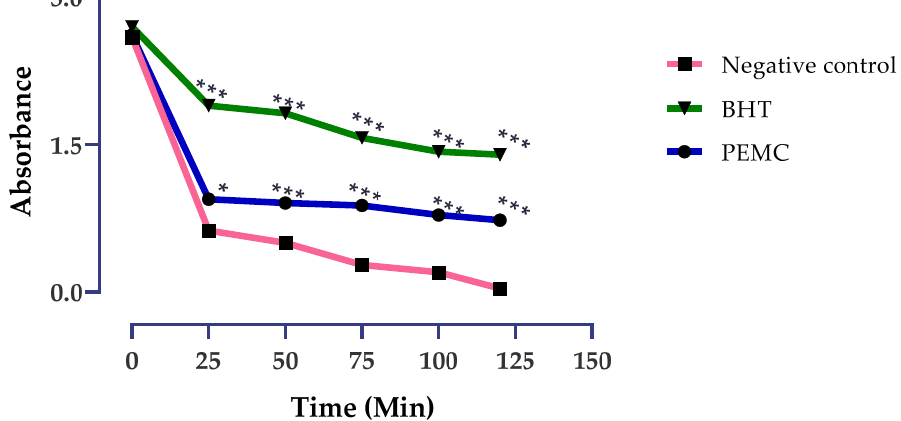
Figure 6. Antioxidant activity of the PEMC, the results are expressed as mean ± standard deviation. The tests were realized in triplicate. * p < 0.05; *** p < 0.001 compared to the normal